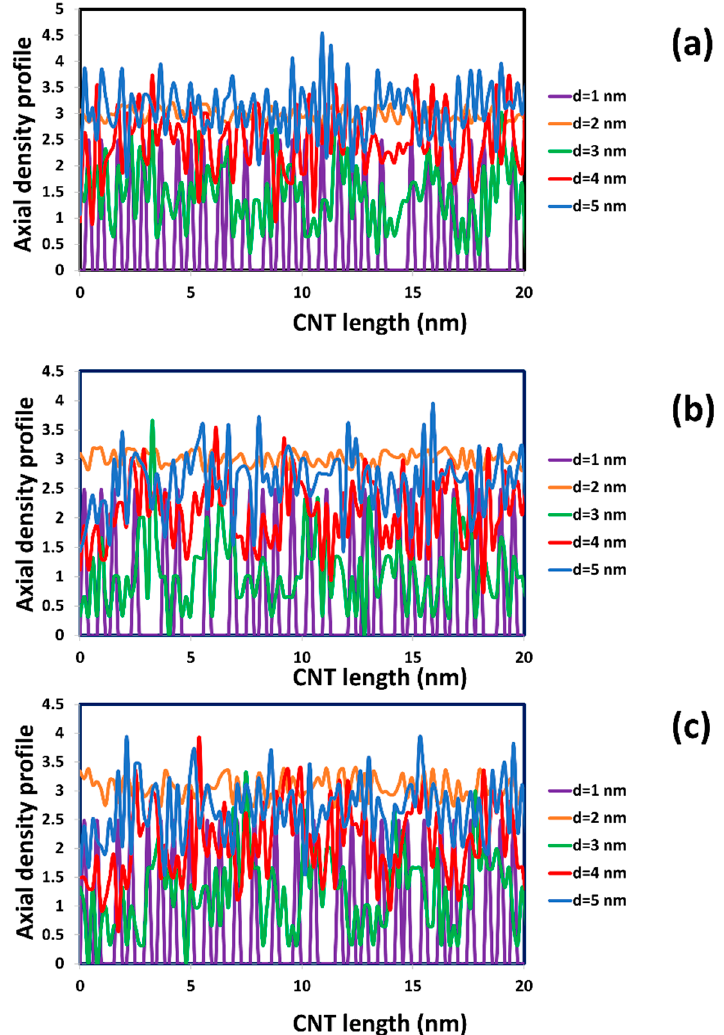
Figure 7. Axial density profile of water inside CNT with SDS adsorption at different total concentration of SDS: 1 wt % ( a ); 2 wt % ( b ); and 3 wt % ( c ).